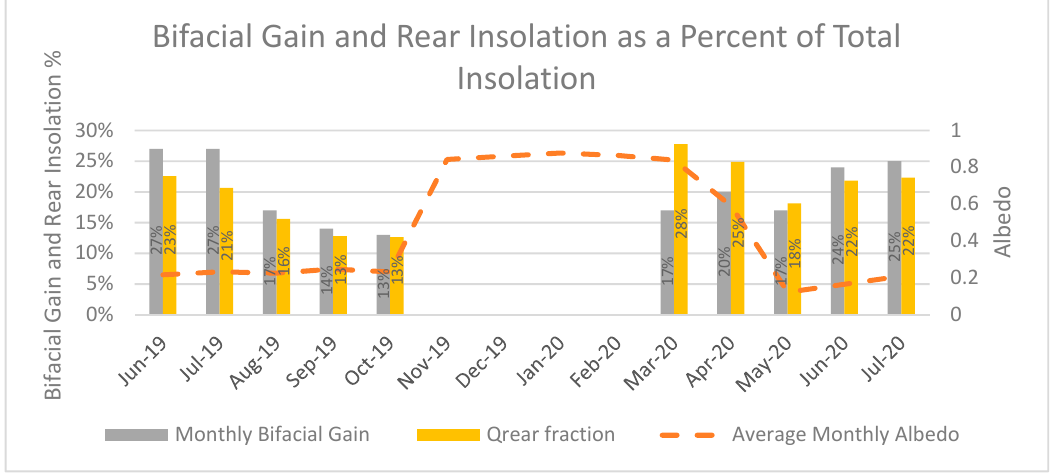
Figure 5. Bifacial gain calculated using Equation (2), the rear irradiance ratio ( Q rear fraction ) calculated using Equation (4), and the average monthly albedo.